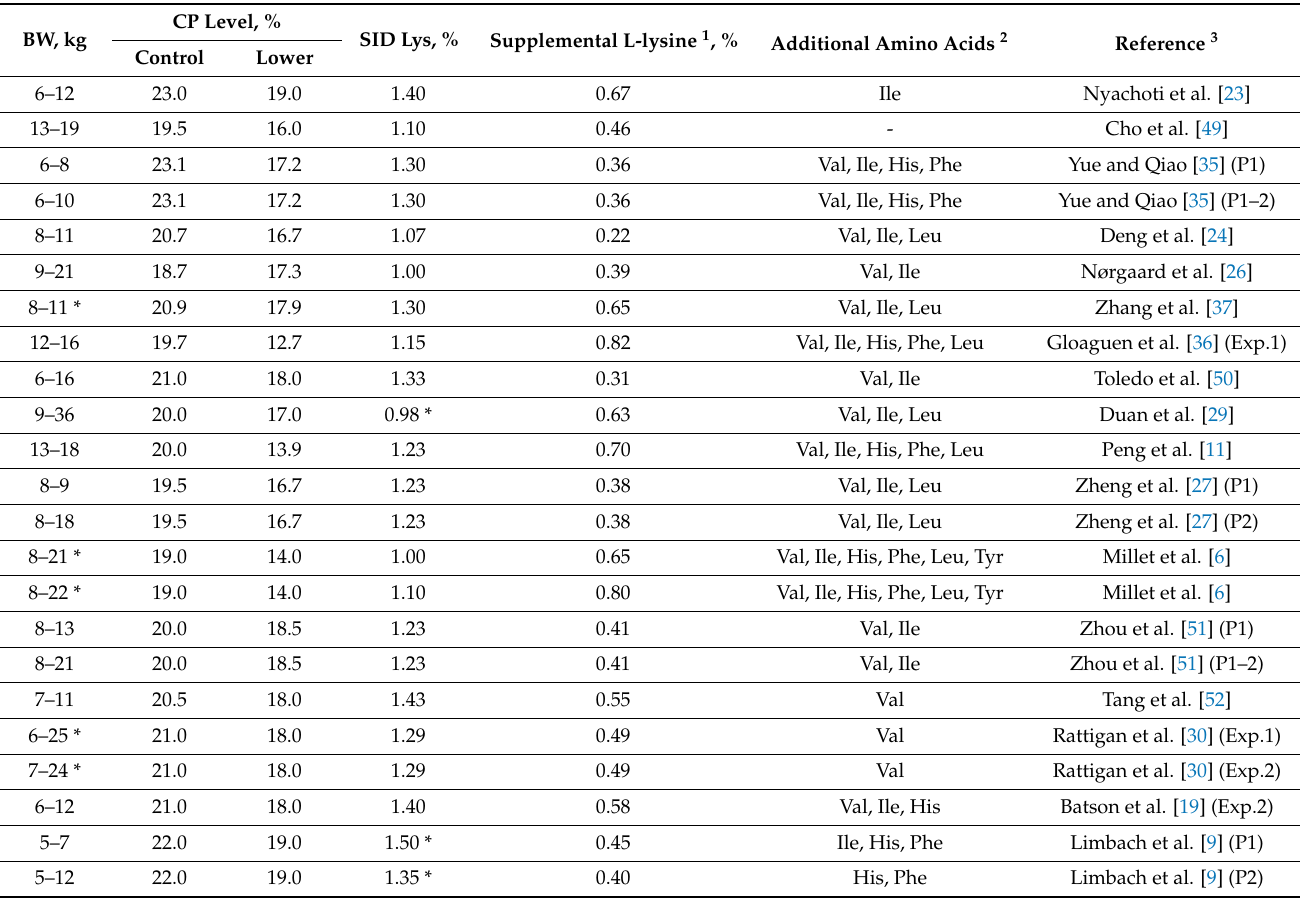
Table 1. Summary of the studies included in the meta-analysis to estimate changes in average daily gain and gain to feed in the nursery